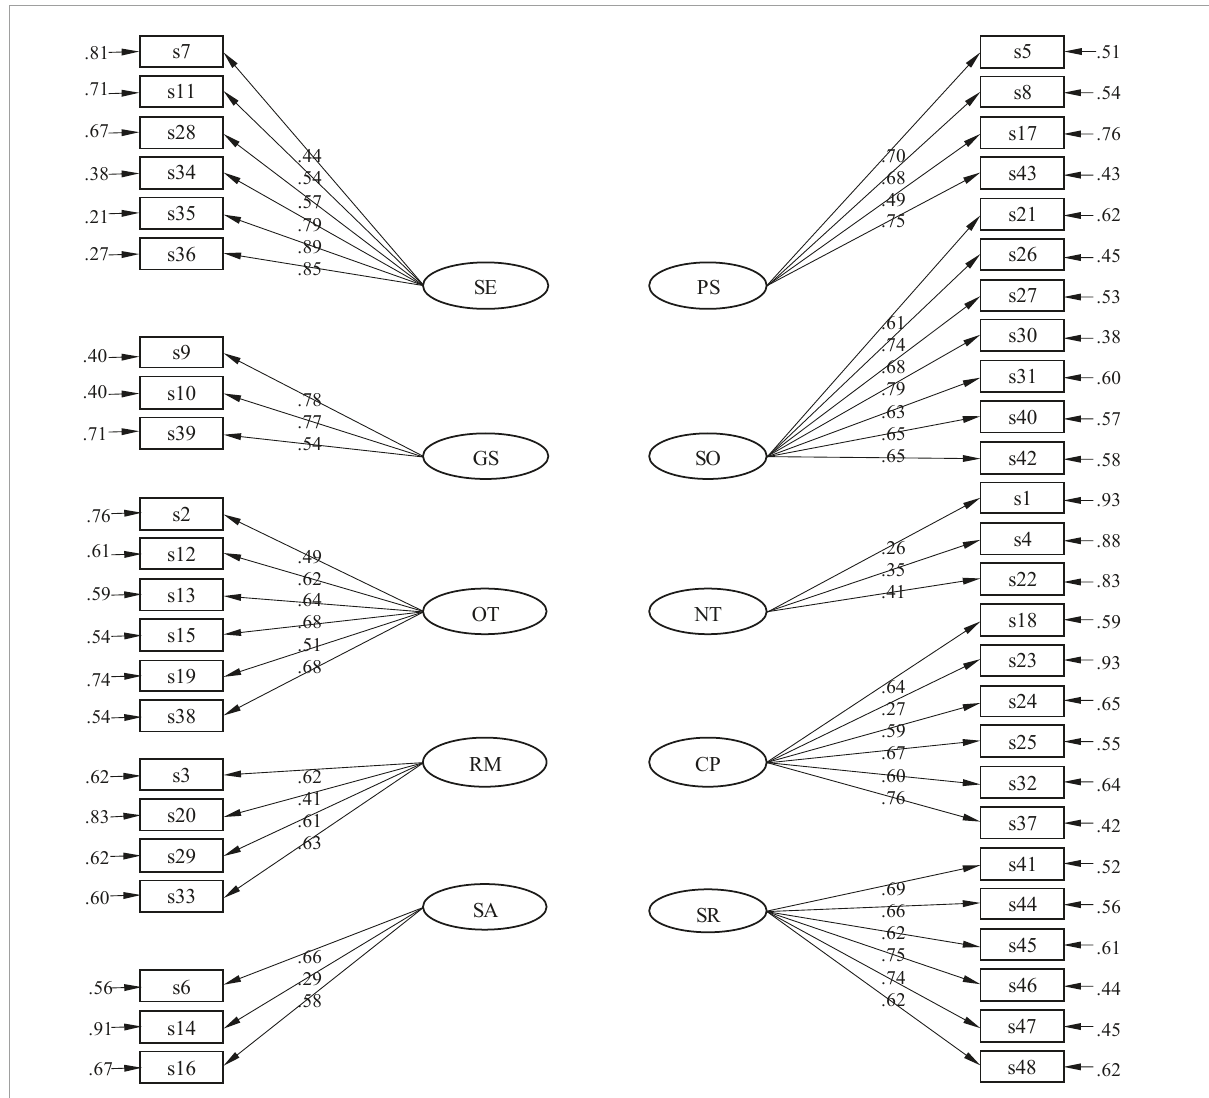
FIGURE1 Structure of English self-regulated learning questionnaire. SE, Self-Evaluation; GS, Goal-Setting and Planning; OT, Organizing and Transforming; RM, Review and Memorization; SA, Seeking Social Assistance; PS, Persistence; SO, Seeking Opportunities; NT, Notes Taking; CP, Comprehension; SR, Self-Reflection. All the factors are correlated with each other. The correlations ranged from 0.59 to 0.95 with a mean of 0.76 and standard deviation of 0.10. These correlation coefficients were not presented in figure for the sake of clarity.